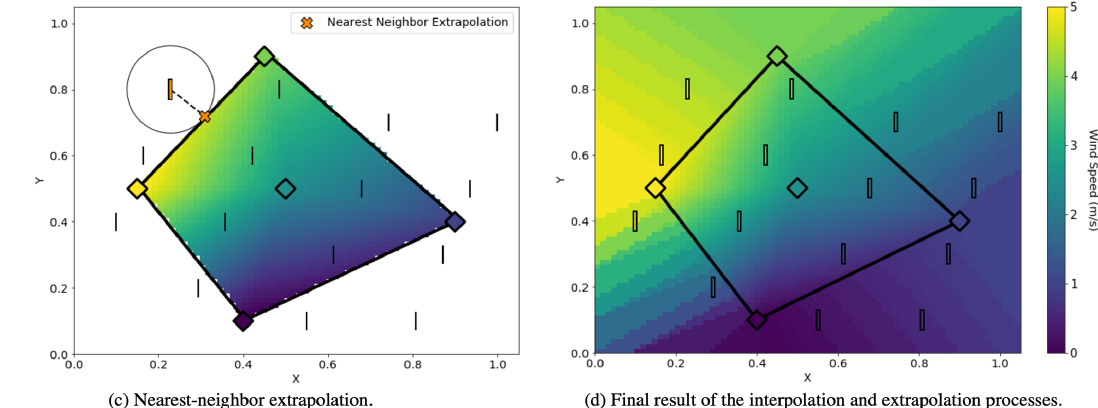
Figure 3. The extrapolation process used to define the remaining values for characterization of the initial state of fluid